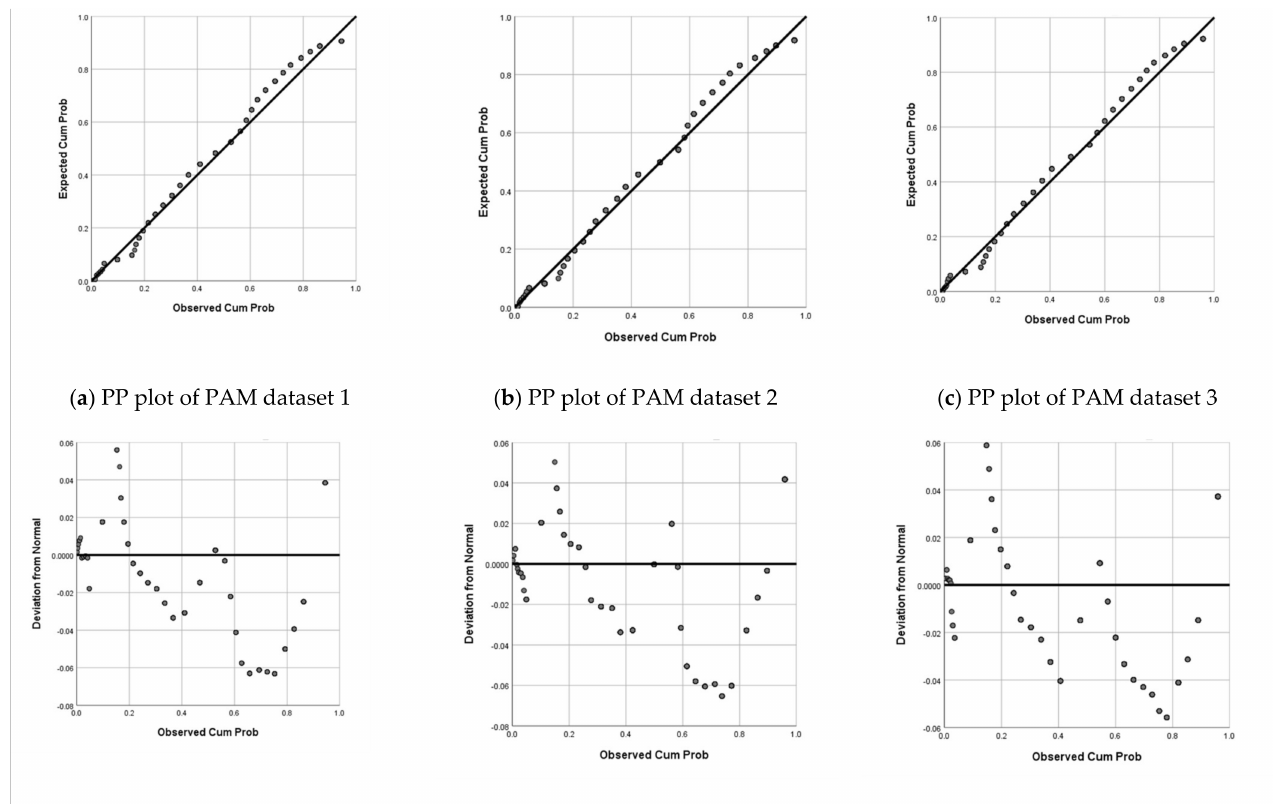
Figure 1. Results of normal distribution